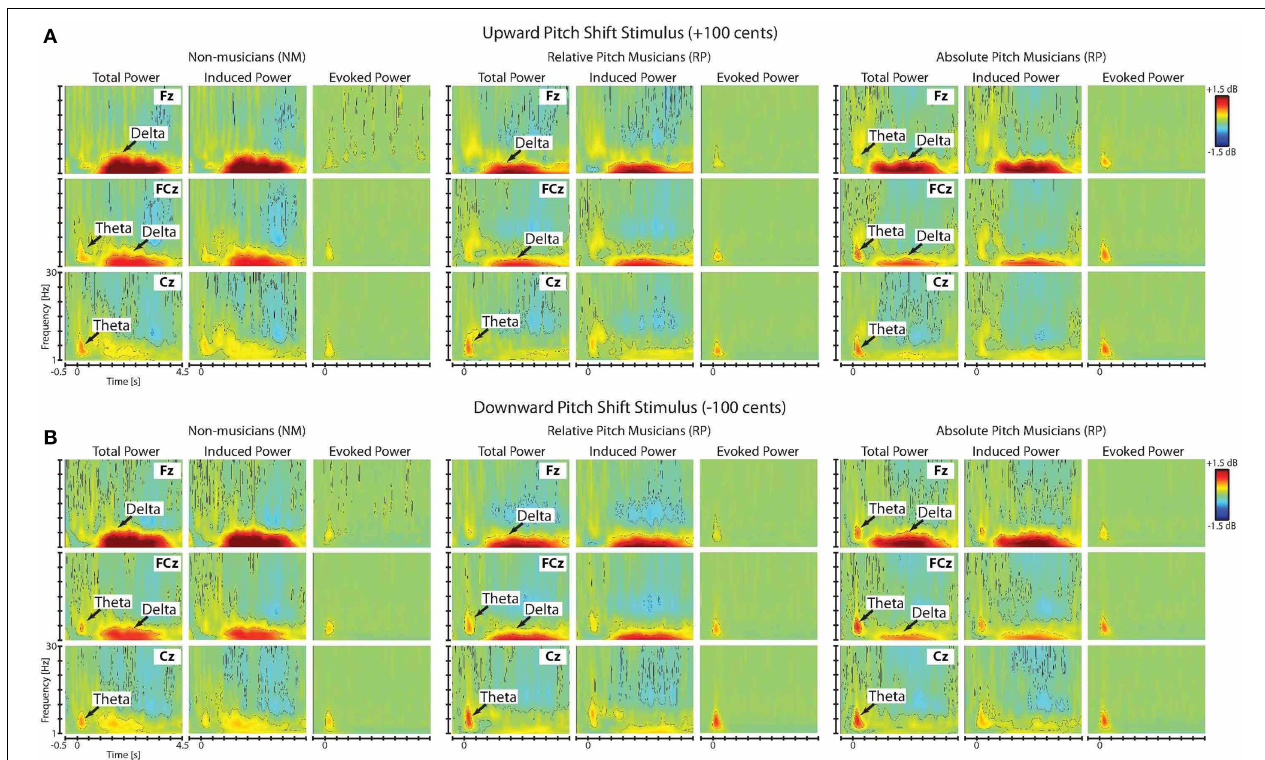
FIGURE 3 | Time-frequency maps of the grand-averaged total, induced and evoked power of the neural responses to (A) upward and (B) downward pitch shift stimuli across non-musicians (NM), relative pitch (RP), and absolute pitch (AP) musicians.